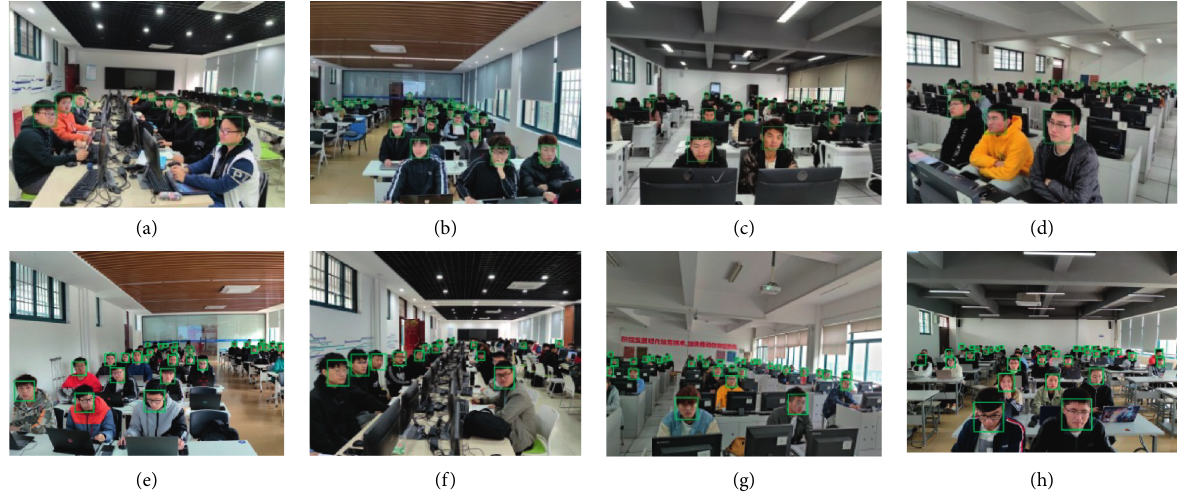
Figure 8: Test effect of self-built classroom dataset.